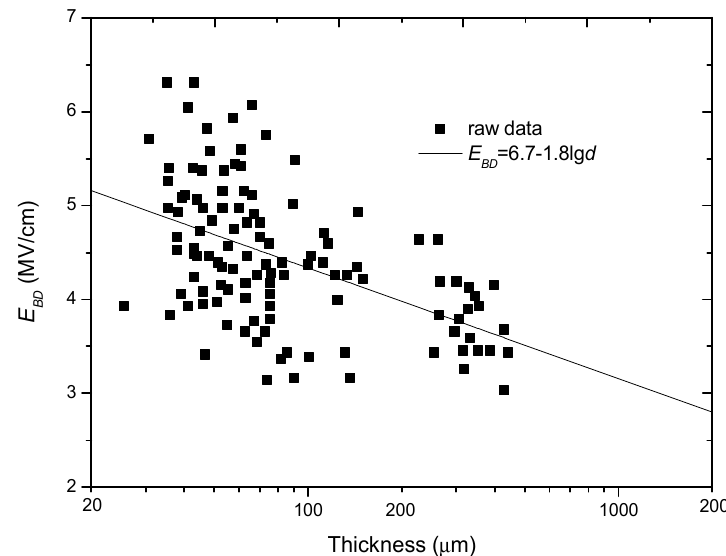
Figure 3. Experimental results to support the minus-single-logarithm relation of E BD with d